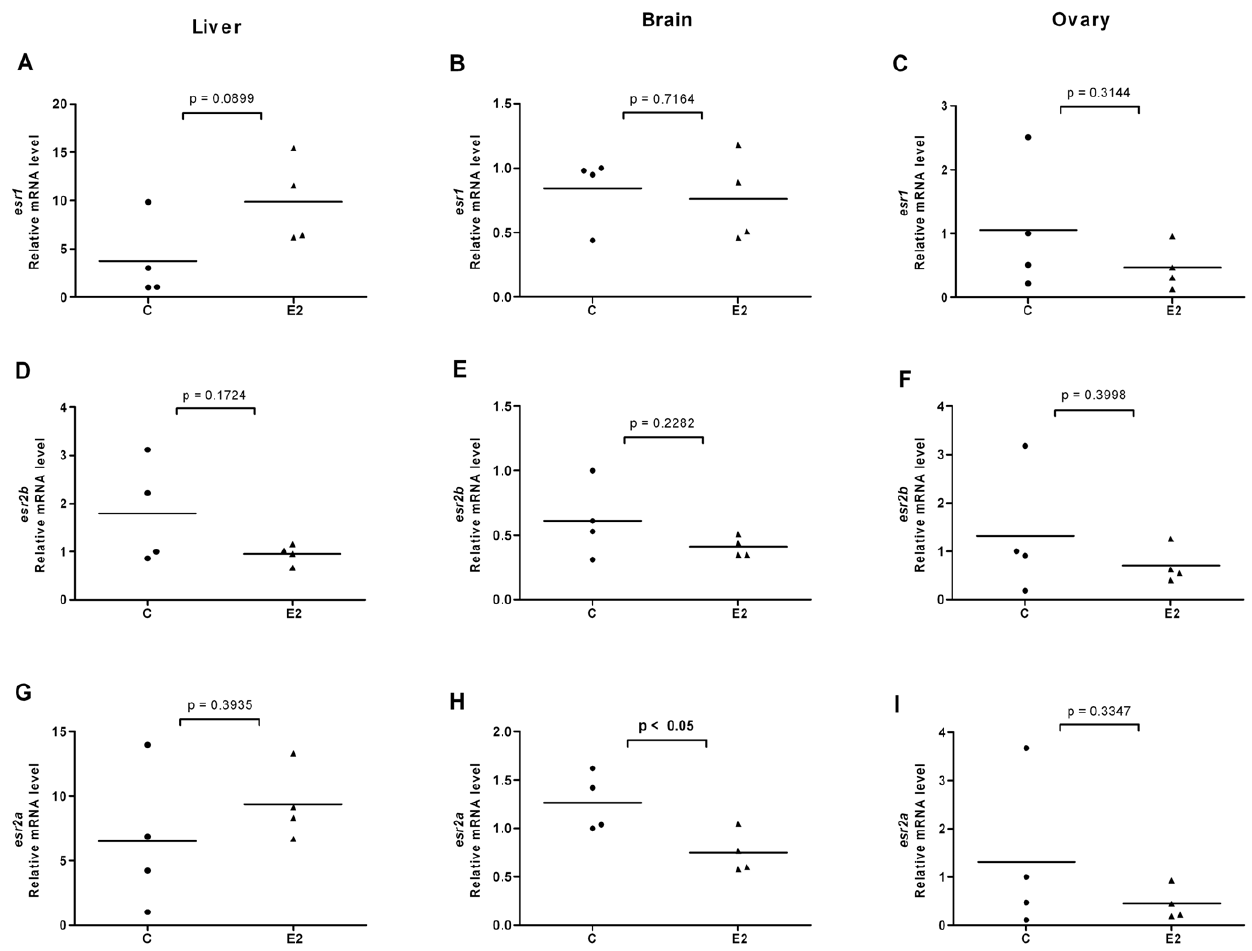
Figure 4. Effects of 17 b -estradiol on esr expression in liver, brain and ovary of female fish. Expression levels of esr1 (A–C), esr2b (D–F) and esr2a (G–I) in liver, brain and ovary of female zebrafish following exposure to E2 (1 m M). Ethanol (0.1%) was used as solvent control and adult females were exposed to E2 or solvent control for 48 h and mRNA levels of esr1 , esr2b and esr2a were quantified. After normalization with beta-actin the expression levels of individual fish of both groups are shown. The mean value is indicated by a